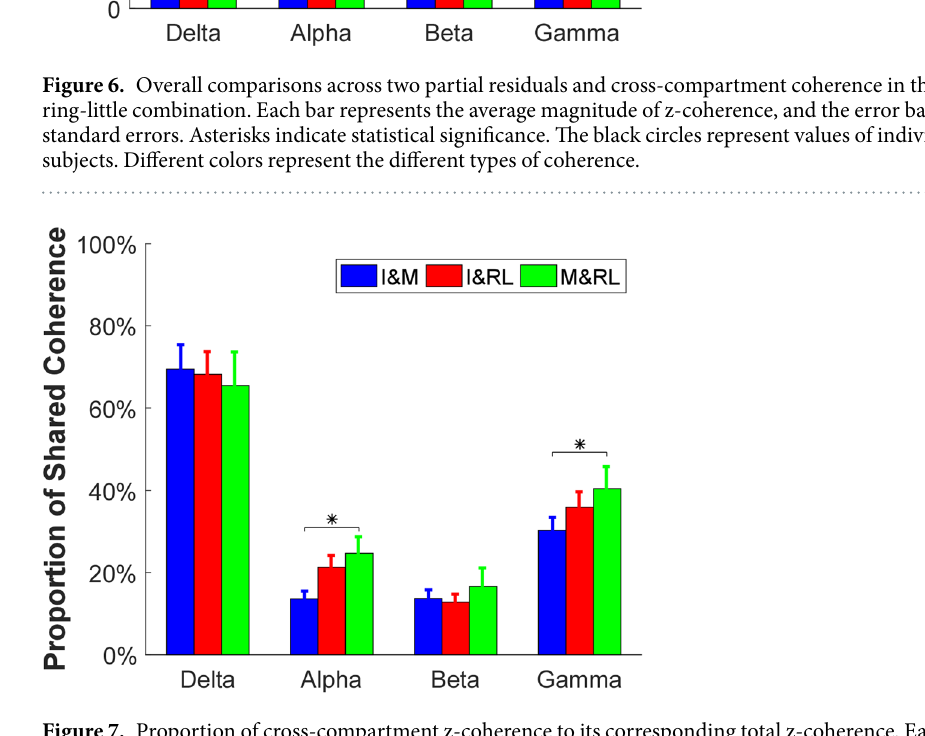
Figure 7. Proportion of cross-compartment z-coherence to its corresponding total z-coherence. Each bar represents the average proportion, and the error bars present the standard error across subjects. Asterisks indicate statistical significance. Different colors represent different types of